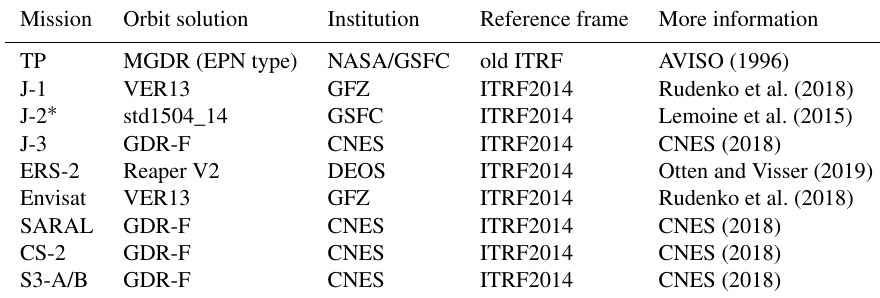
Table A1. Orbit solutions used for the different altimetry missions.